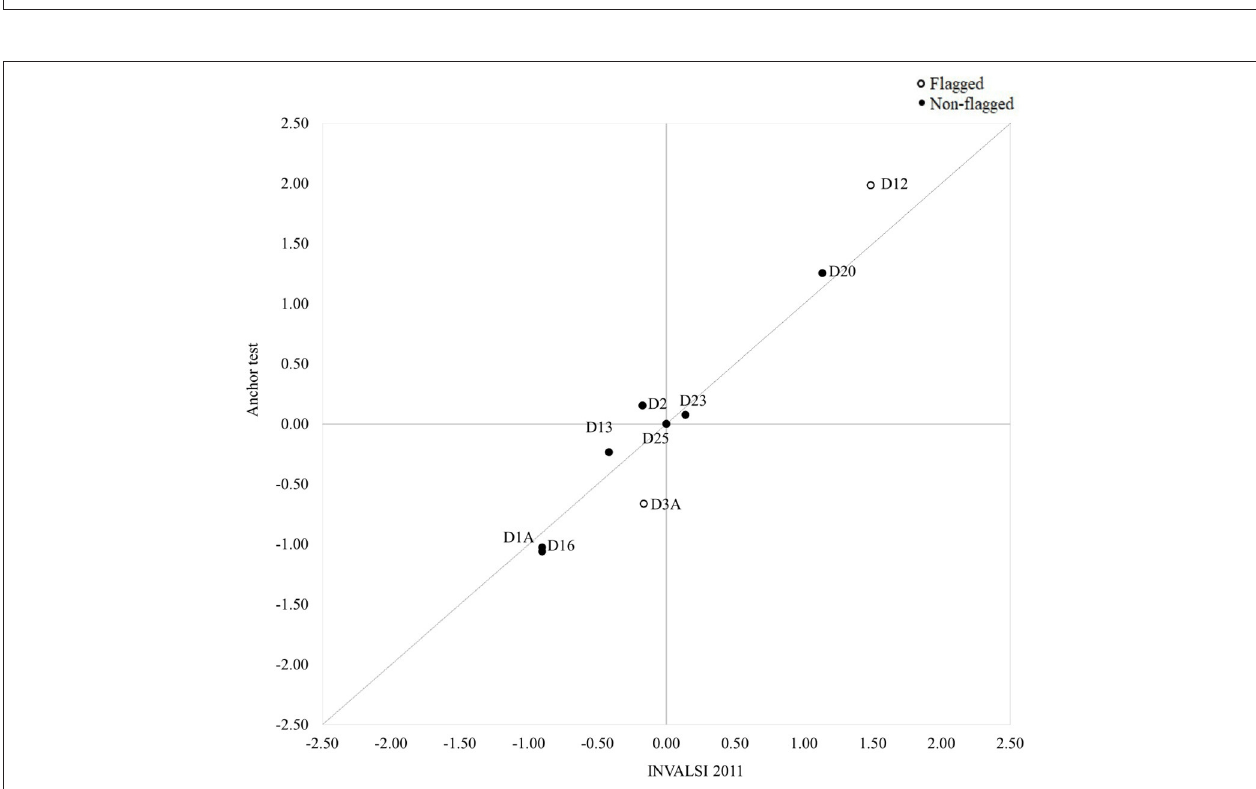
FIGURE 3 | Cross-plot: Difficulty (logit) of common items as estimated in the INVALSI [34] and anchor test forms (full set: r = 0.97; reduced set: r = 0.98).